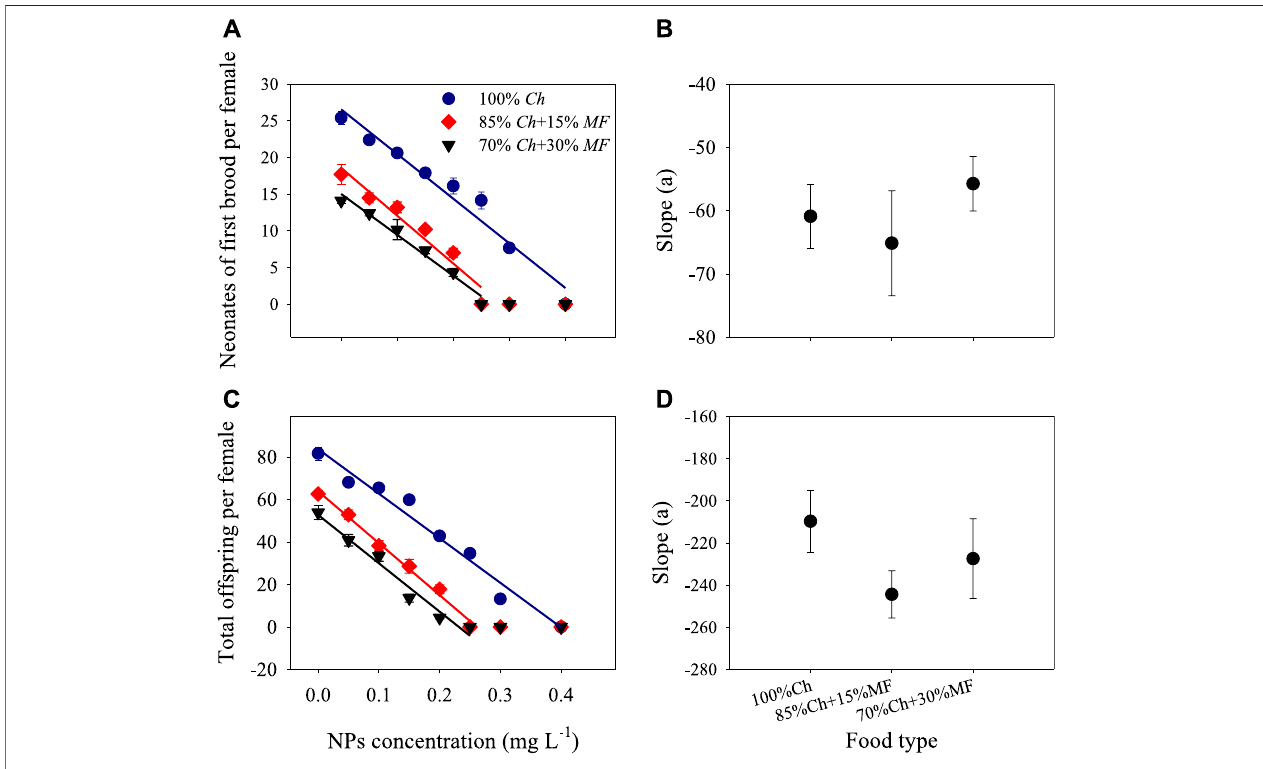
FIGURE 3 | Reproductive performances and their slopes of Daphnia in different treatments. Some error bars were too short and covered by the data symbol.